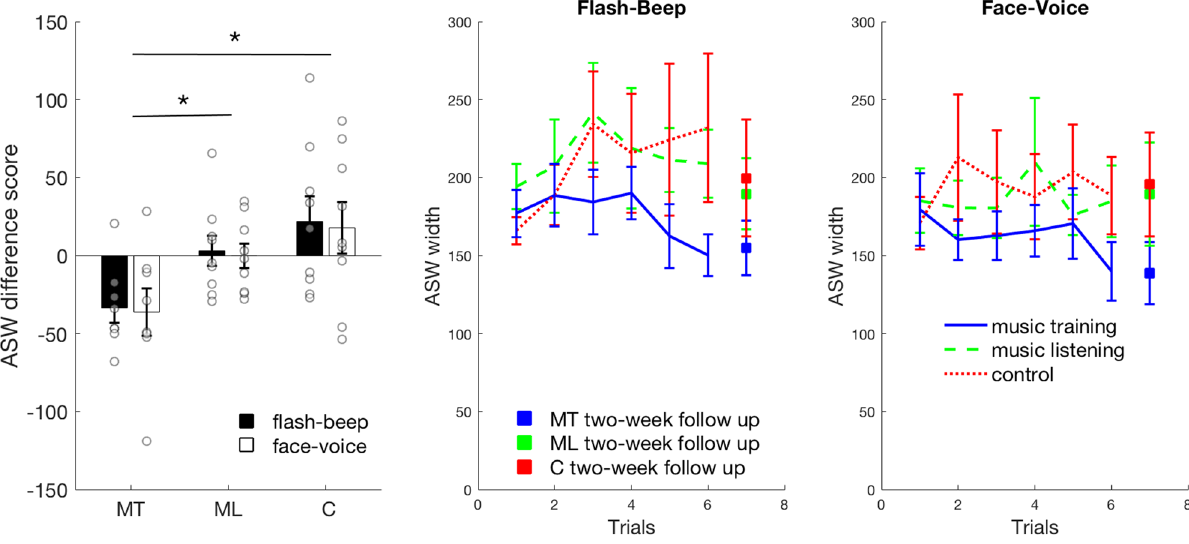
Figure 2. Left panel: improvement in audio-visual synchrony window (ASW difference score) was calculated as difference between the size of ASW at the last testing session and that measured at the first testing session. Negative numbers represent an improvement and a narrowing of the ASW, while positive numbers represent a worsening or enlargement of the ASW. An ASW difference score of zero indicates no difference in ASW by the end of the study. Middle and Right panel: line charts showing the group average ASW width as a function of number of trials (six bi-weekly test sessions) for flash-beep (middle panel) and face-voice (right panel) for MT (blue colour), ML (green colour), and C (red colour) group. The solid squares represent the group average ASW width at the two-week follow-up after the training ended. MT = music training group; ML = music listening group; C = control group. Error bars represent errors standard of the means and circle represent the individual data. * p < 0.05. See also Fig. S3 in the supplemental materials for participants’ individual ASW measures as a function of number of trials and for a regression analysis of the data when considering the different